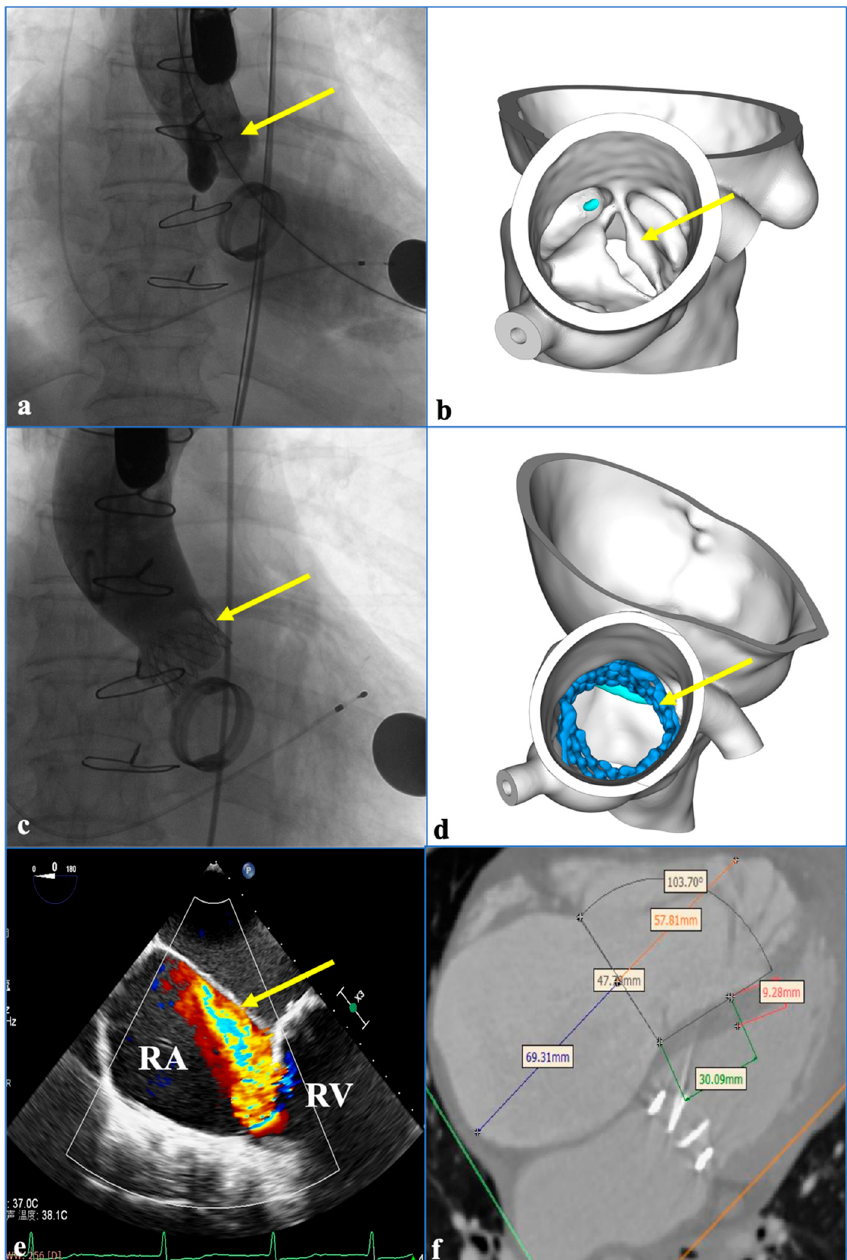
Figure 2. Images before transcatheter tricuspid valve replacement. ( a ) Digital subtraction angiography image before transcatheter aortic valve replacement (TAVR) in 2021; the arrow indicates the patient’s aortic stenosis. ( b ) Three-dimensional reconstruction before TAVR; the arrow points to the patient’s aortic stenosis. ( c ) Digital subtraction angiography shows that the aortic valve stent is fixed securely in place; the arrow points to the stent. ( d ) Three-dimensional reconstruction after TAVR; the arrow points to the stent. ( e ) The yellow arrow points to the massive regurgitation in TV. Chinese words in Figure 2e are temperature. ( f ) The assessment of the computed tomography angiography images before TTVR. RA: right atrium; RV: right ventricle.